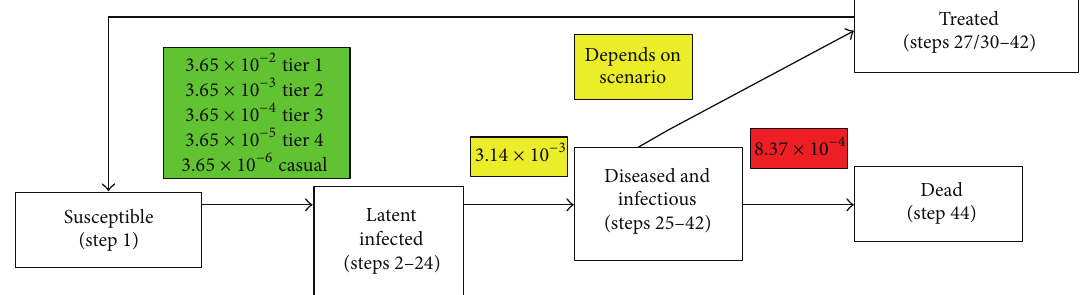
Figure 3: Flow diagram of states and transition probabilities per month for each individual